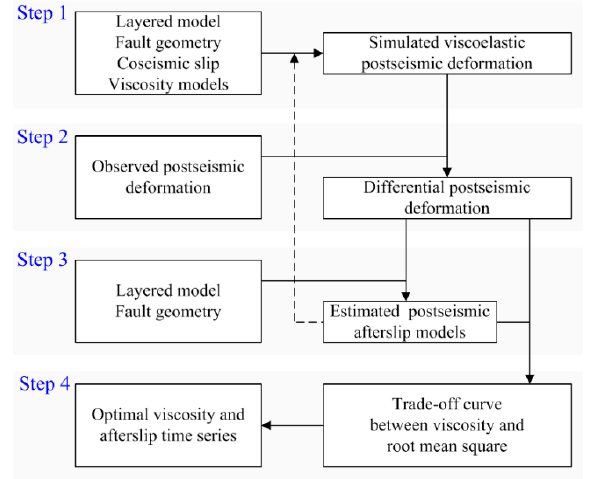
Figure 3. Flowchart of modeling postseismic deformation time series with a combination model of afterslip and viscoelastic relaxation. Both coseismic slip and the accumulated afterslip models occurring before the current time epoch are used to drive the viscoelastic relaxation.